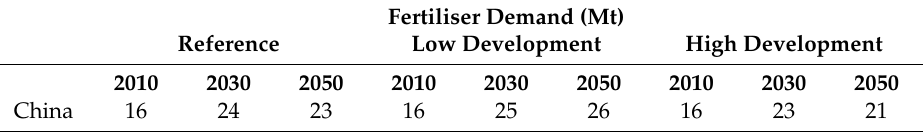
Table 14. Fertiliser demand for reference, low and high development scenarios.